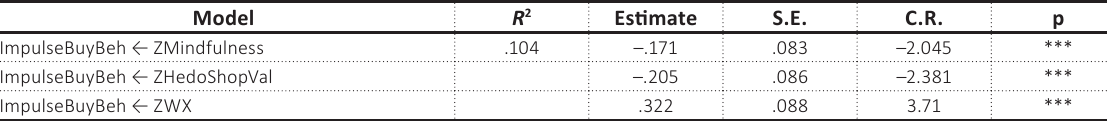
Table 8. The regression weight results of the moderator role of hedonic shopping value Model R 2 Estimate S.E.